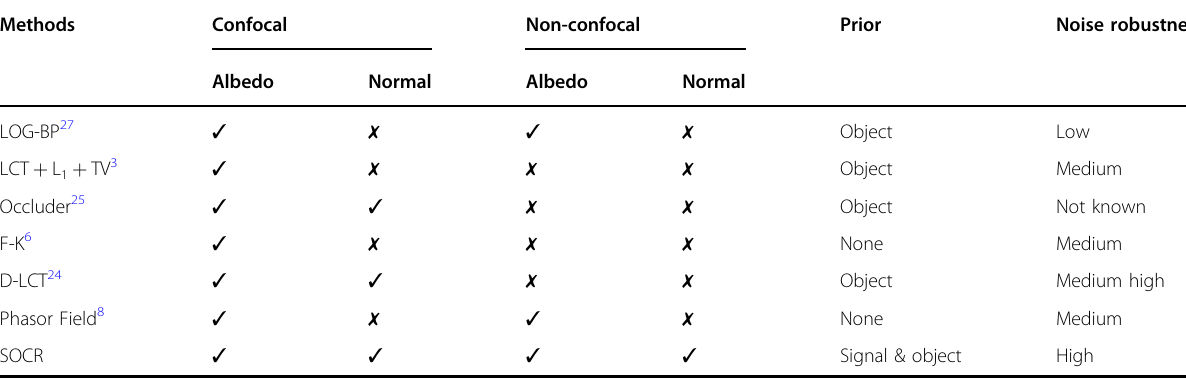
Table 1 Comparisons of voxel-based NLOS reconstruction algorithms